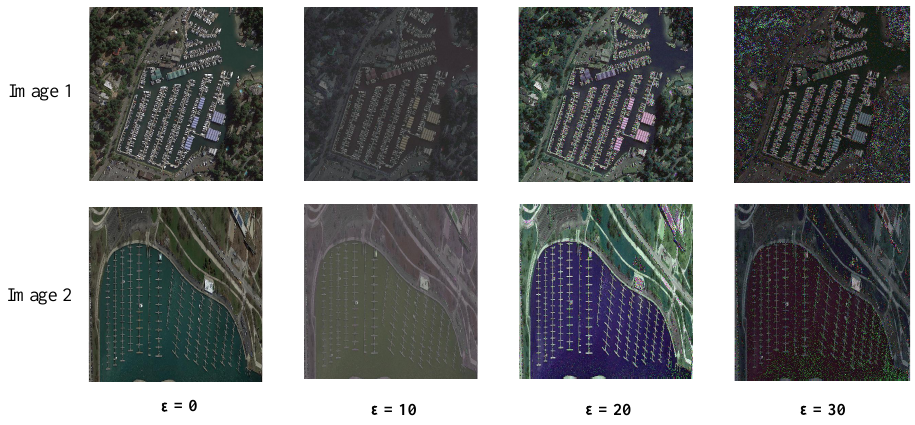
Figure 3. The influence of different noise coefficients on remote sensing